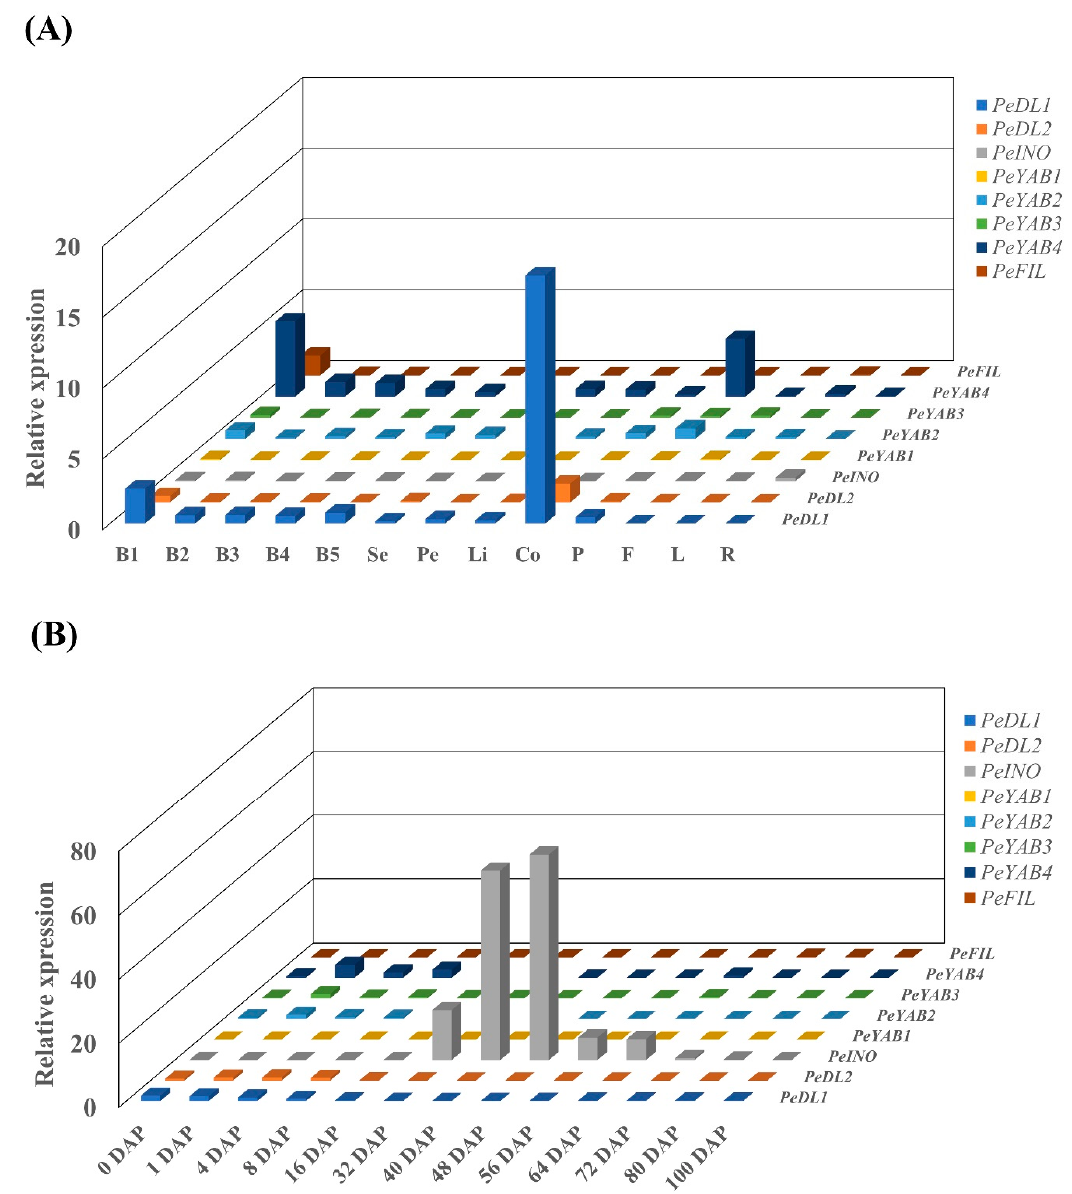
Figure 8. Expression patterns of PeYABBY -related genes in P. aphrodite subsp. formosana . ( A ) Expression patterns of PeYABBY -related genes in various organs. ( B ) Expression patterns of PeYABBY -related genes in various ovule developmental stages. B1–B5, stage 1 to stage 5 floral buds; Se, sepals; Pe, petals; Li, lip; Co, column (gynostemium); P, pedicel; F, floral stalk; L, leaf; R, root; and DAP, days after